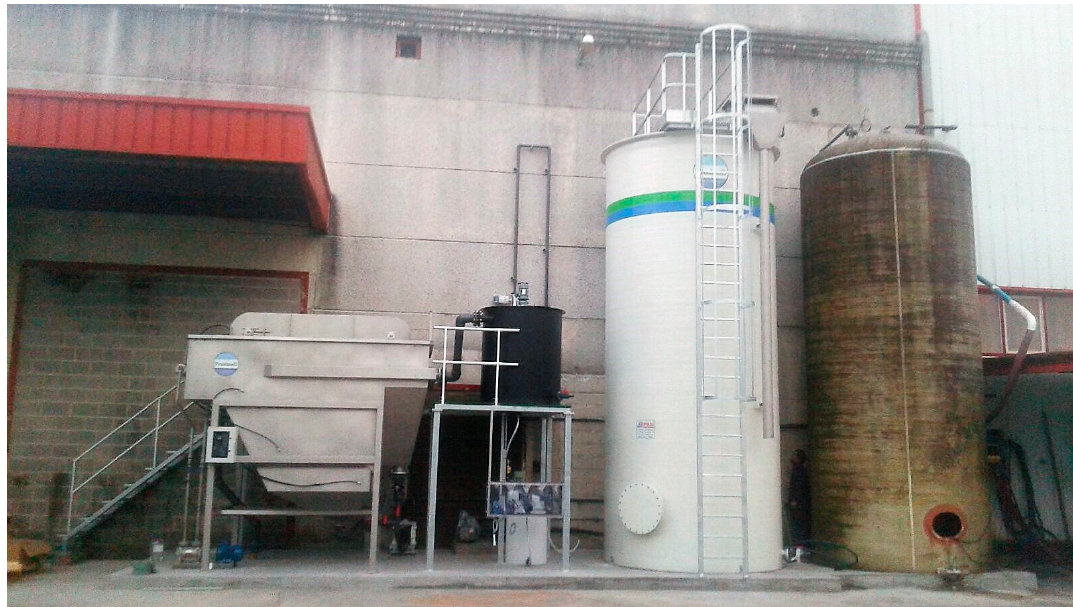
Figure 3. New pretreatment installed in February 2018 by company 3.